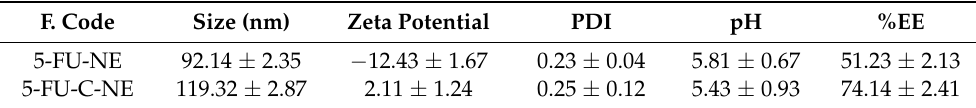
Table 1. Physicochemical properties of the nanoemulsion.